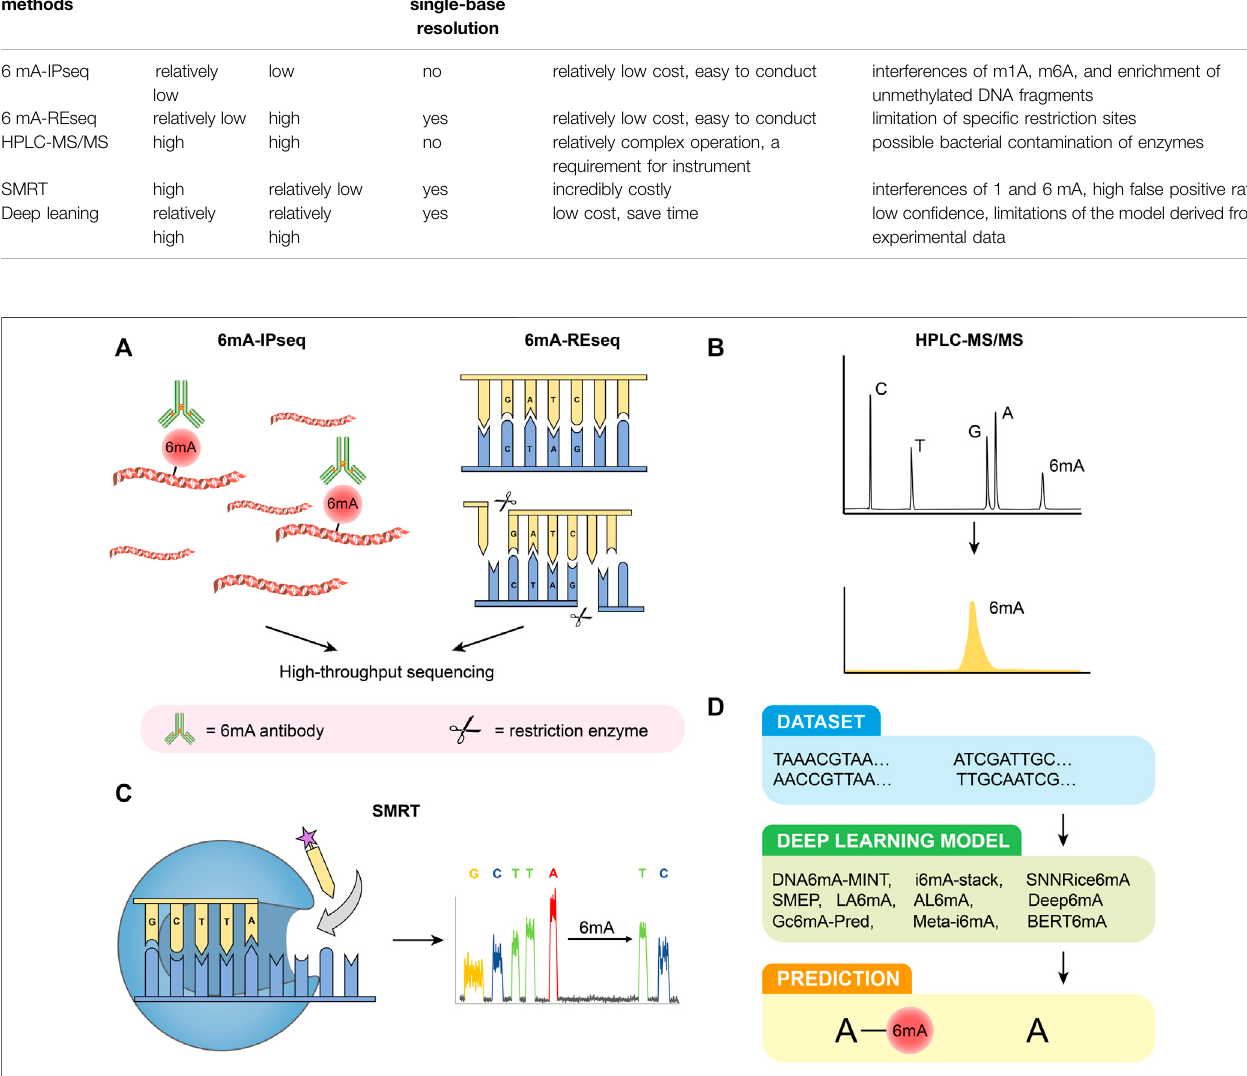
Frontiers in Genetics |